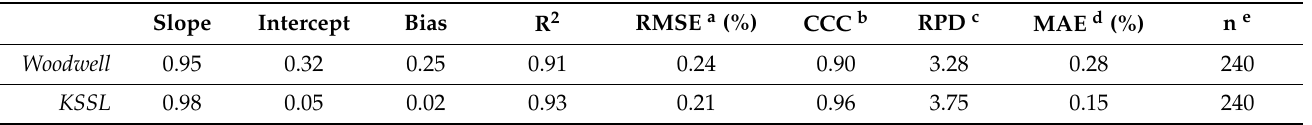
Table 3. Goodness of fit statistics for linear regression of observed and predicted soil organic carbon concentration using Woodwell spectra and KSSL